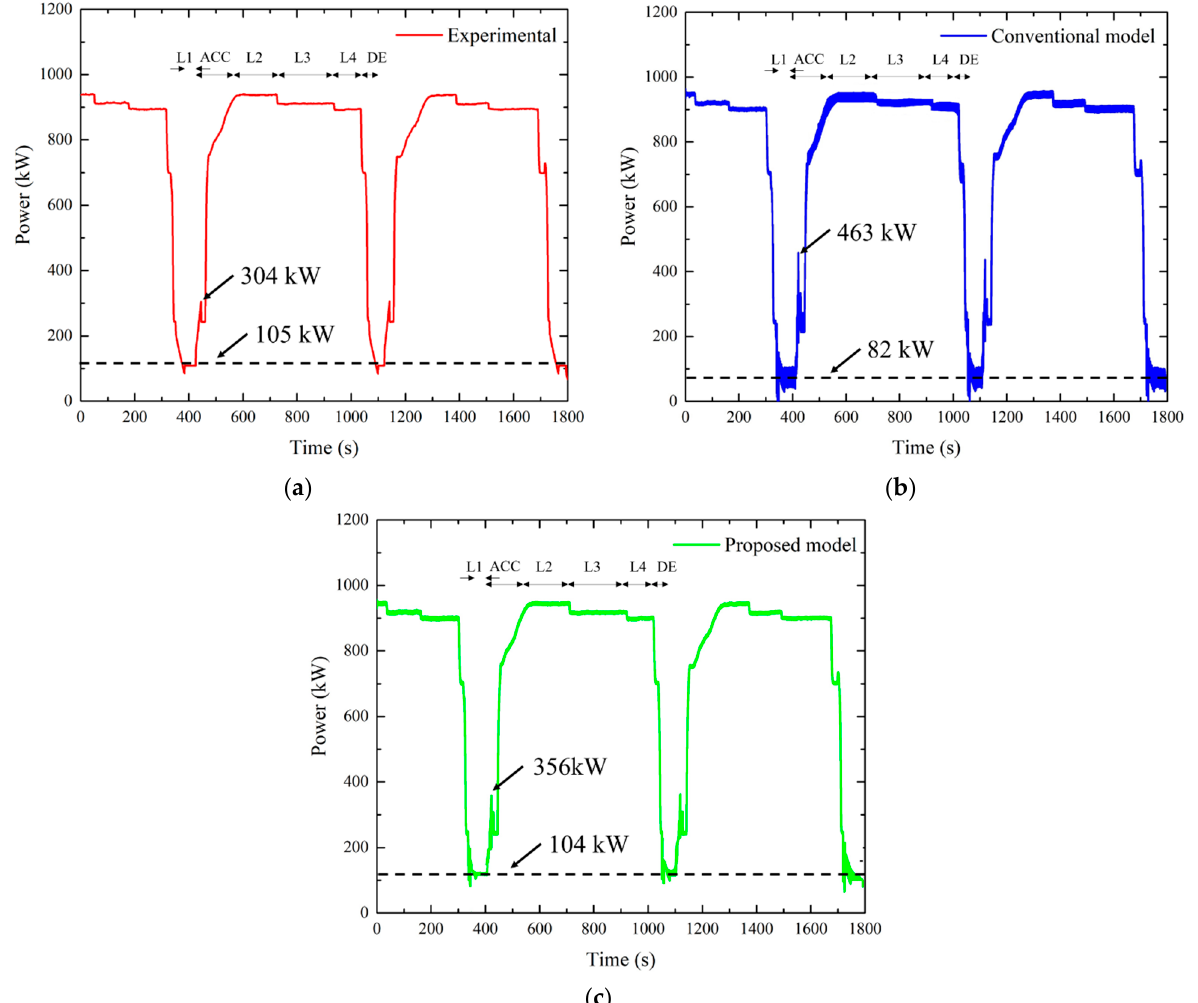
Figure 9. Powers comparison. ( a ) Experimental; ( b ) Conventional model; ( c ) Proposed model. Table 5. Comparison of kilowatt hours and computational times.